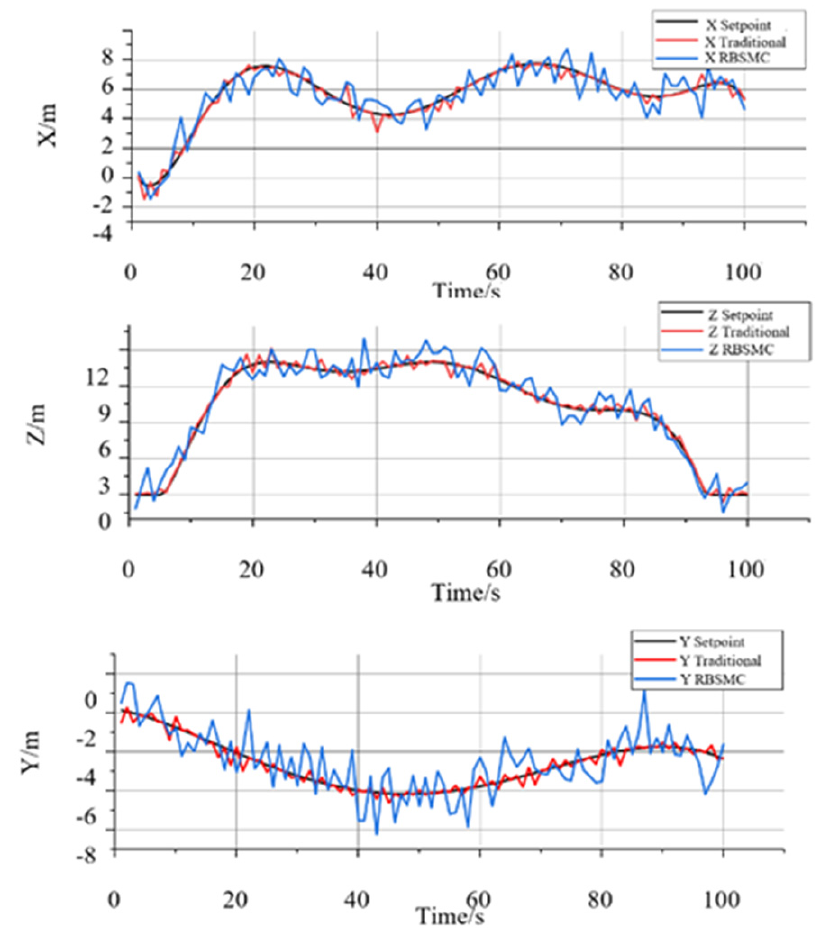
Figure 7. Traditional versus RBSMC positions.